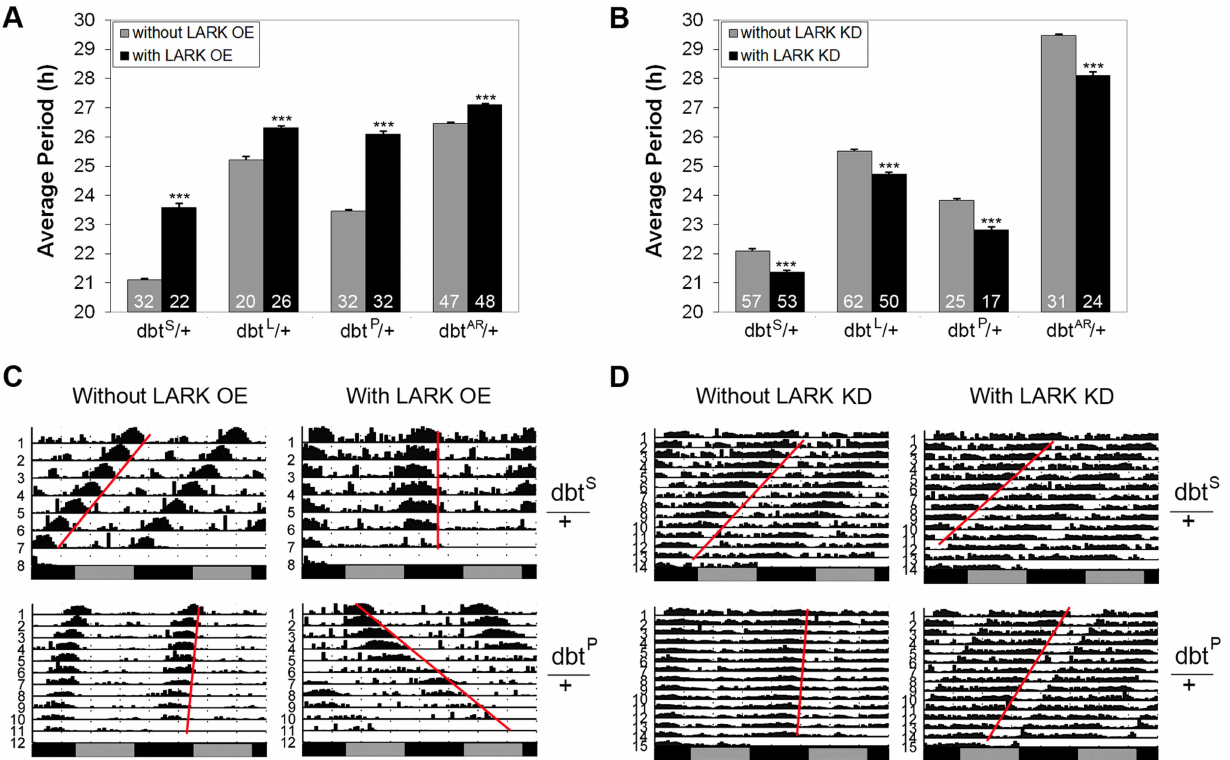
genotype. Error bars represent SEM. p , 0.0001 for all comparisons. C and D, Representative activity plots. For interactions involving LARK OE, genotypes are: without LARK OE, w 1118 ; pdf-gal4/ + ; Tub-gal80 ts /dbt . With LARK OE, w 1118 ; pdf-gal4/ + ; Tub-gal80 ts uas-lark/dbt . For interactions involving LARK KD, genotypes are: without LARK KD, w 1118 ; pdf-gal4 uas-dicer2/ + ; + /dbt , with LARK KD, w 1118 ; pdf-gal4 uas-dicer2/ + ; lark 1 uas-lark RNAi /dbt ( dbt here refers to dbt S , dbt L , dbt P , or dbt AR ).